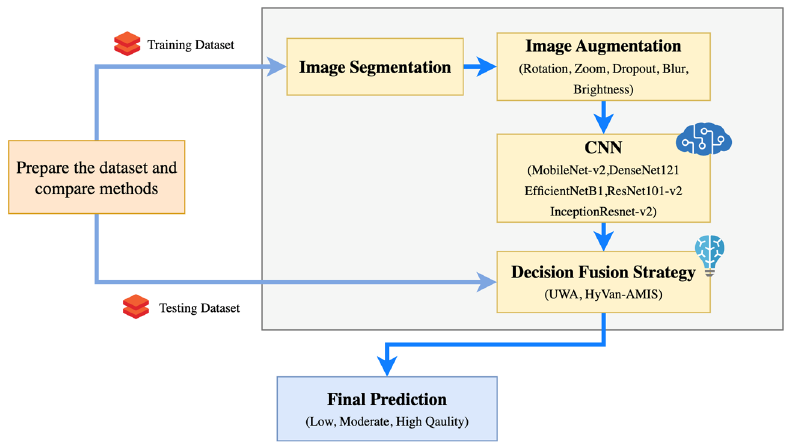
Figure 2. Framework of the method.